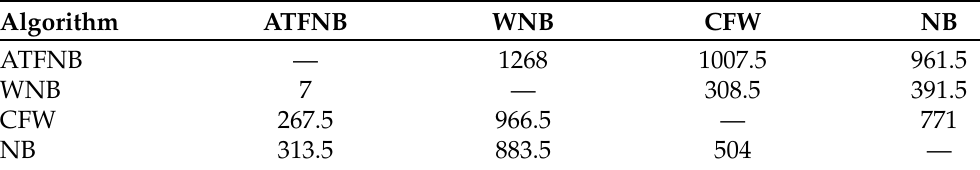
Table 7. Ranks of the Wilcoxon test with regard to ATFNB on UCI datasets.